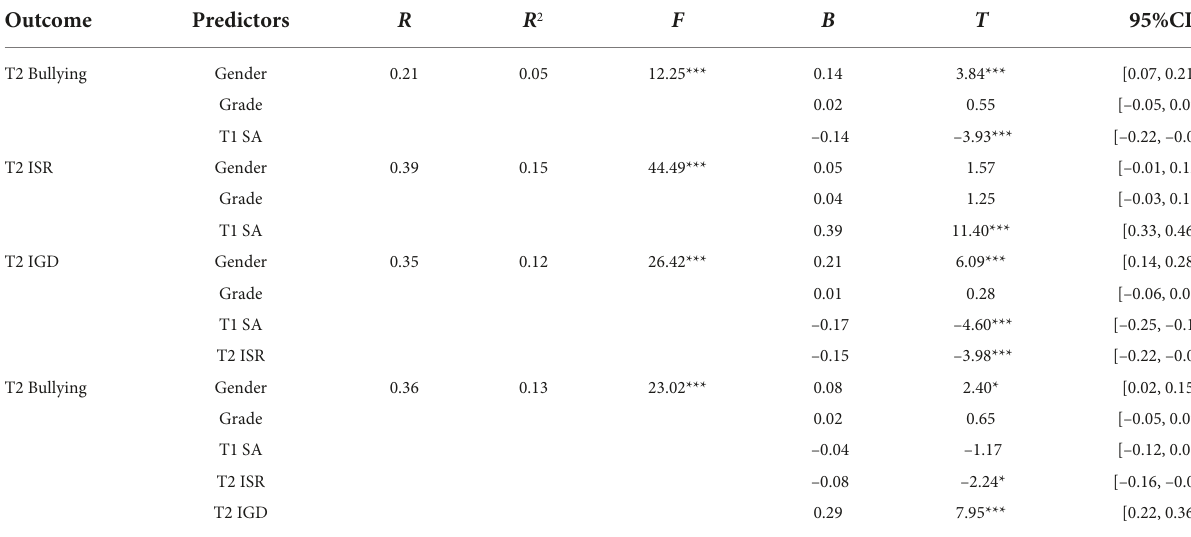
TABLE 3 Testing the serial multiple mediation